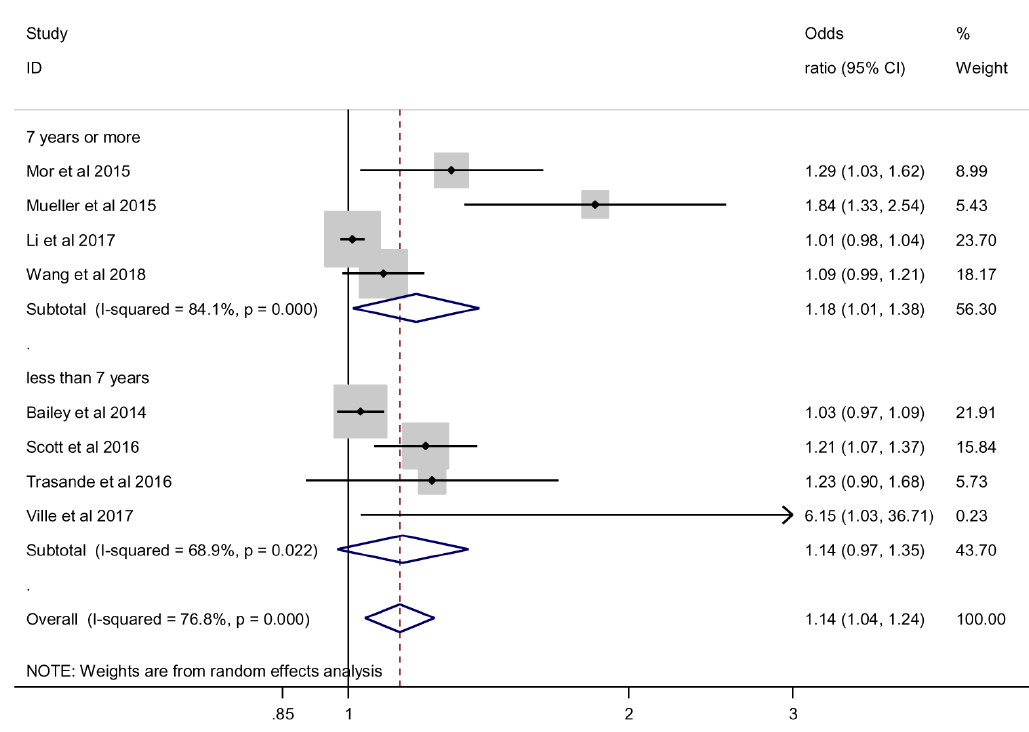
exposures.Figure 9. Obesity outcome, subgroup analysis by time-point of outcome